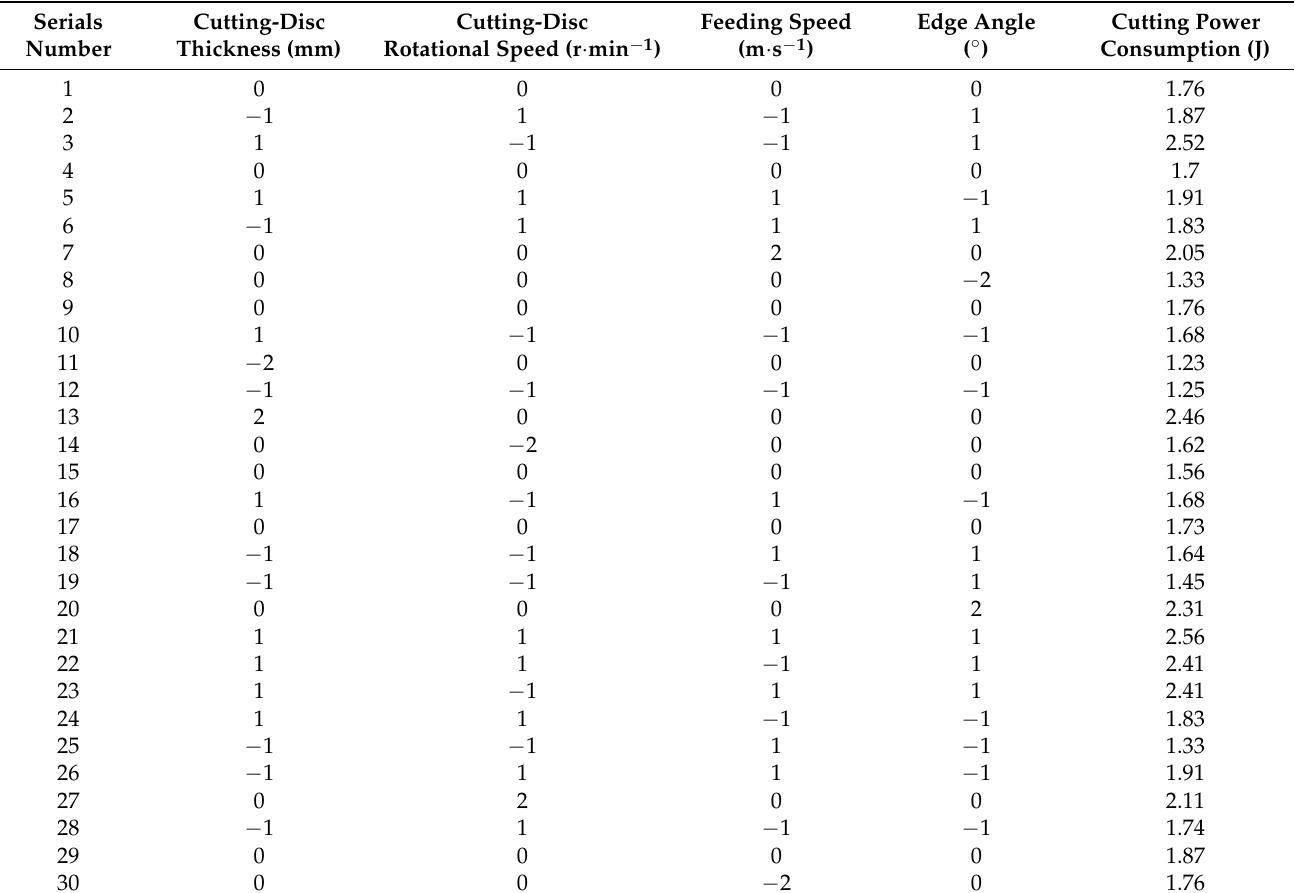
Table 3. Test design and results.